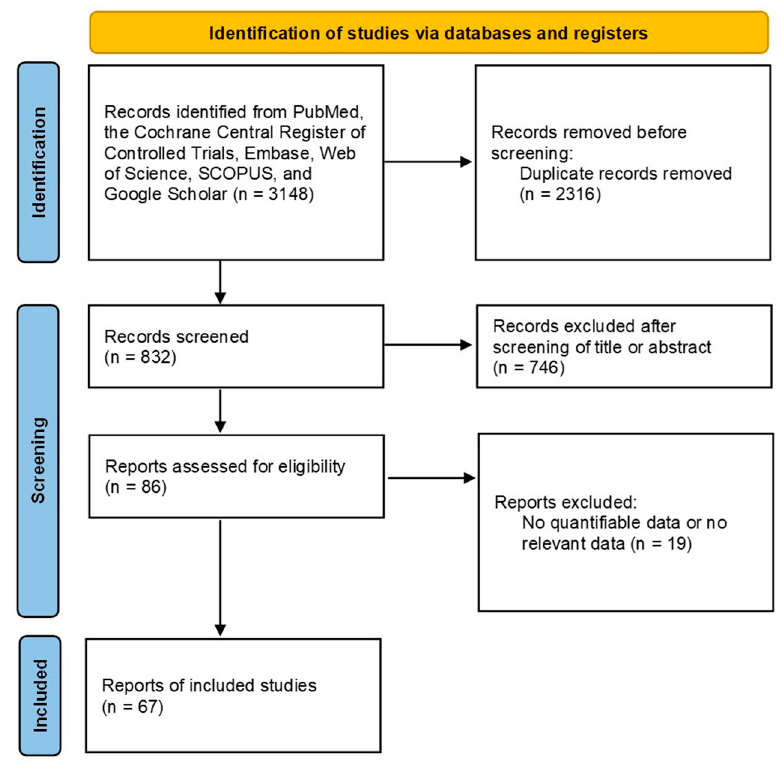
Figure 1. Flowchart of the study selection process for meta-analysis.